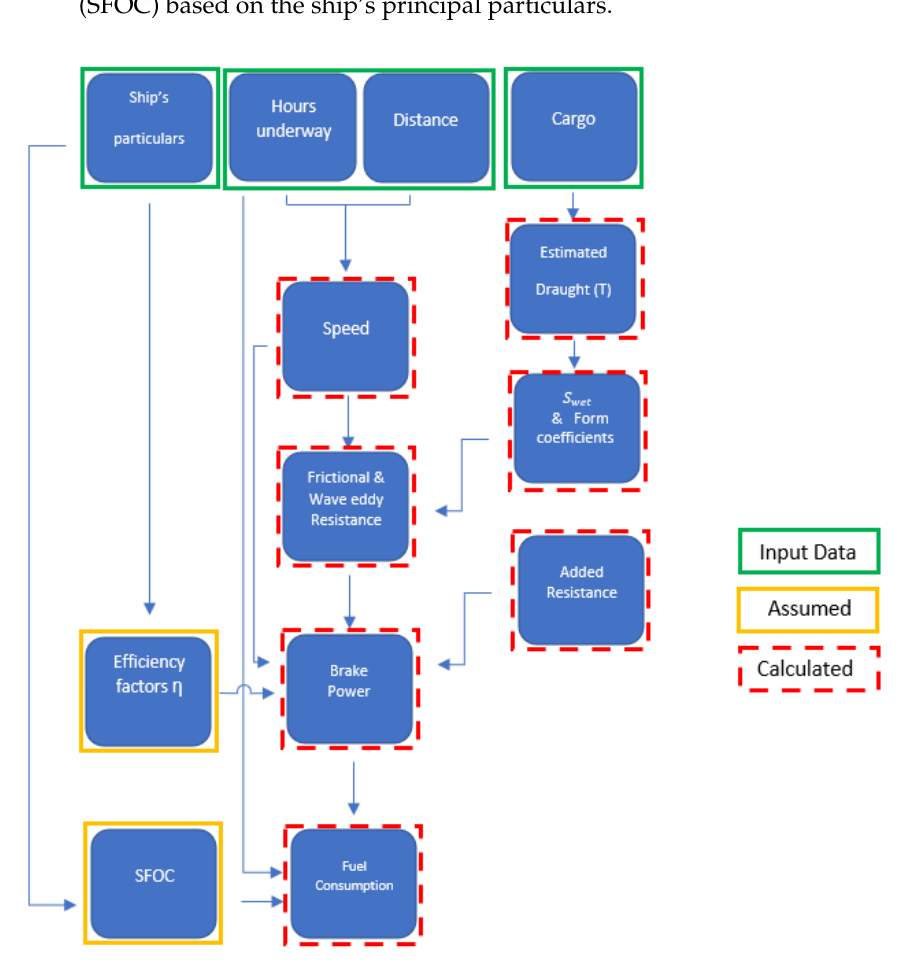
Figure 1. Schematic representation of the SNAM.